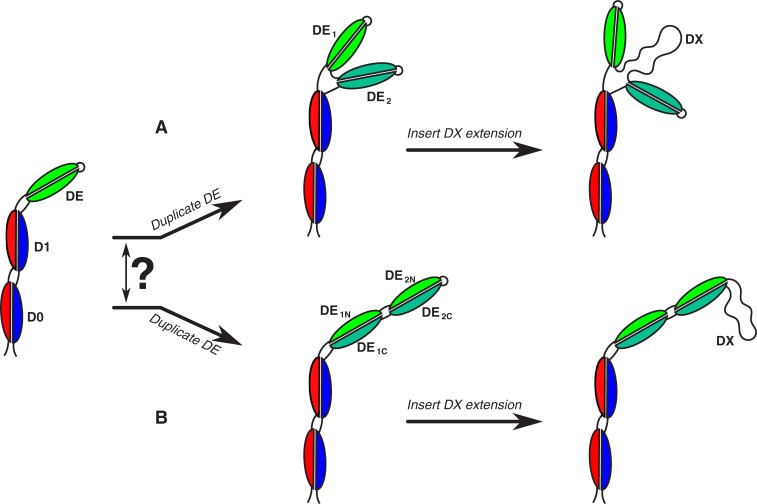
A model for evolution of the Oceanospiralles giant flagellin.Two possible scenarios for protein folding are conceivable: (A) the DE region duplicates and the two discrete DE sequences fold into discrete domains. Subsequent generation of the DX insert would make a more bulky flagellin. (B) Alternatively, the DE region duplication leads to two split domains, wherein the two physical DE regions are comprised of disparate parts of the two contiguous DE sequences. Subsequent insertion of the DX insert would make a longer protrusion at the surface.